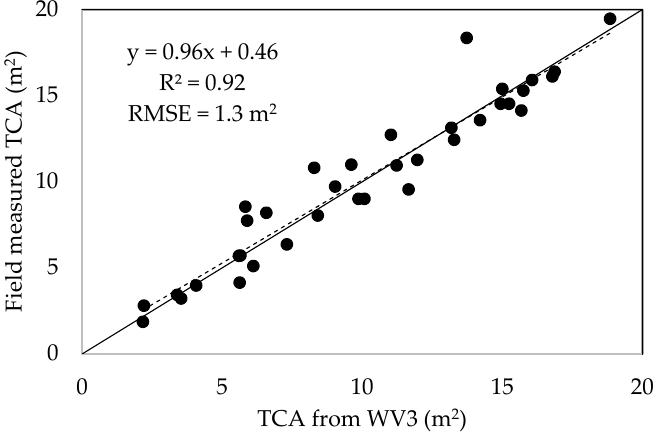
Figure 5. The relationship between field measured TCA and pan-sharpened WV3 delineated TCA with test set data. The solid line indicates the 1:1 relationship.